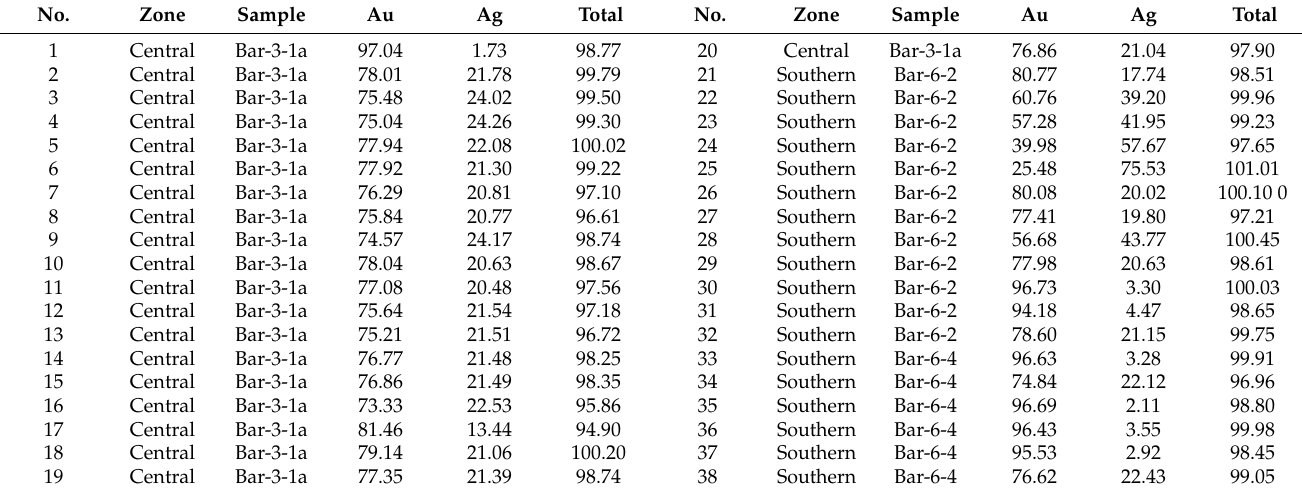
Table 4. Composition of Au-Ag minerals in the gold-pyrite-quartz association from various zones of the Baranyevskoe deposit, wt. %.